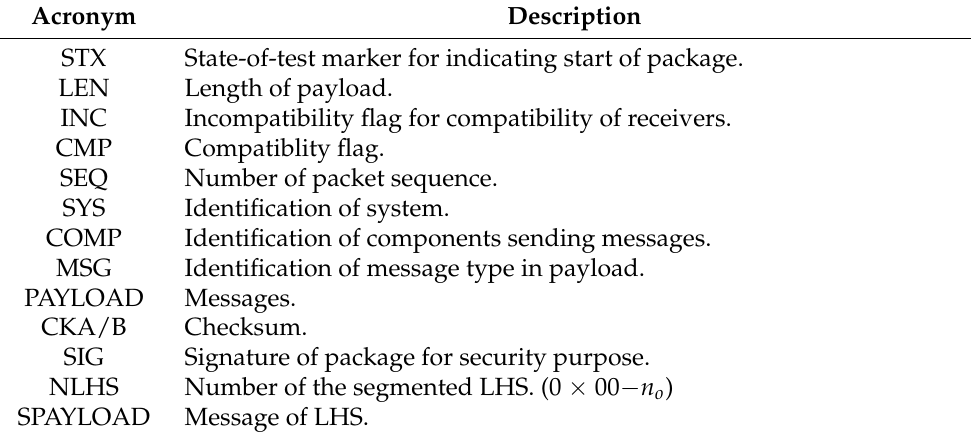
Table 1. Explanation of E-MAVLink